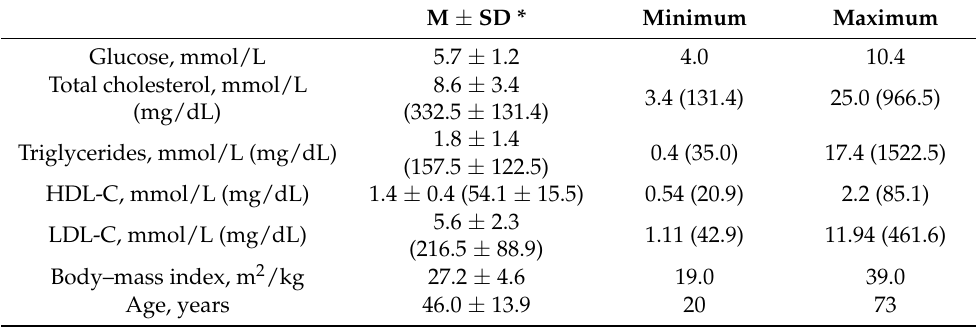
Table 1. Data on biochemical testing of the subjects over 18 years of age, n = 69.